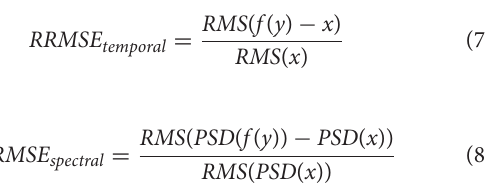
Frontiers in Neuroergonomics |